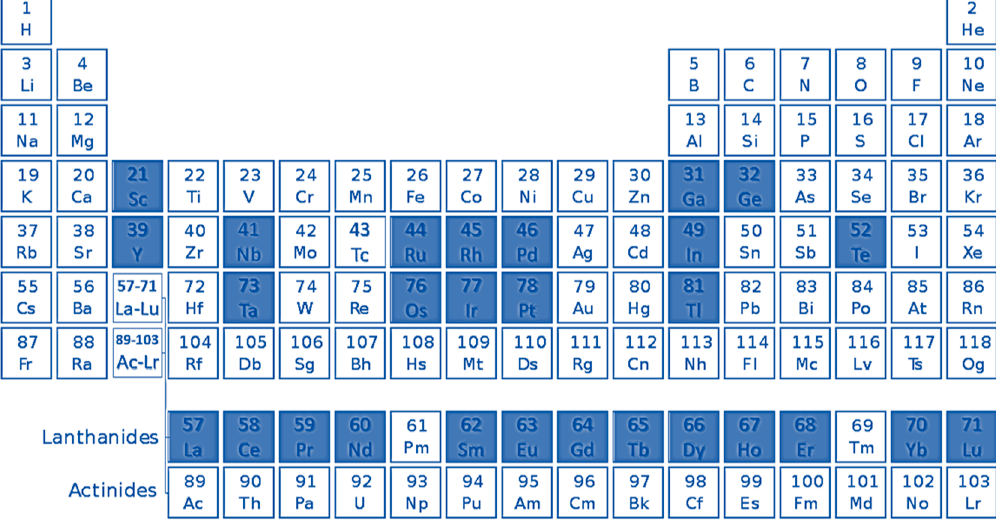
Figure 3. Criticality assessment of rare earth elements (REEs) and other elements in the medium term (2015–2025). It is represented in green the elements that are not critical, in yellow the near-critical elements and in red the critical elements.